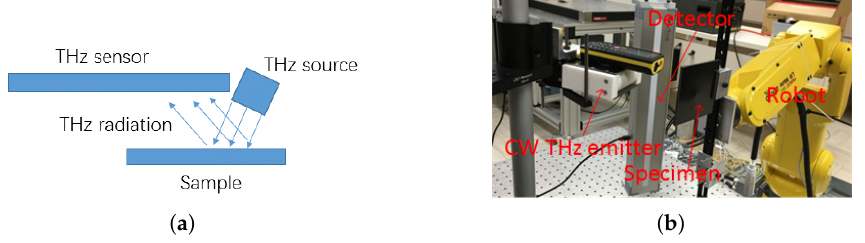
Figure 7. CW THz configuration in reflection mode: ( a ) schematic set-up; ( b ) experimental